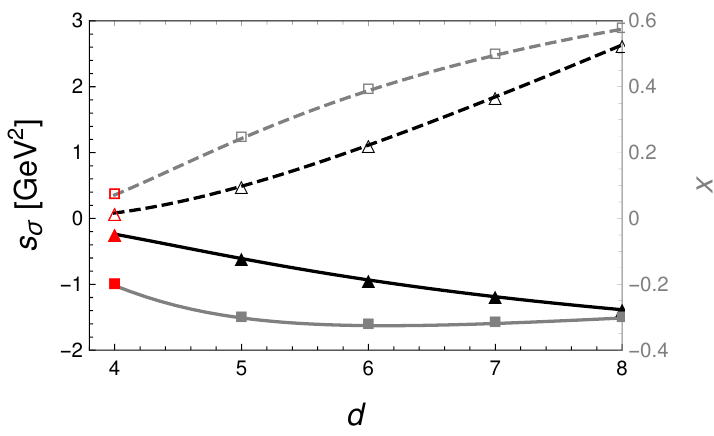
Figure 4 . Real and imaginary parts of s σ (using the left vertical axis) as functions of d plotted using dashed and solid (black) lines, respectively. The empty and filled triangles show the values for integer d . We also plot the real and imaginary parts of x (using the right vertical axis) with dashed and solid gray lines respectively. The empty and full squares are the corresponding values for integer d